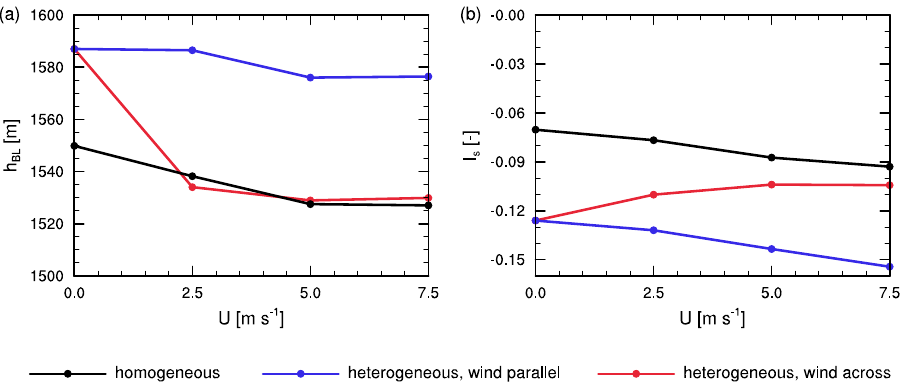
Fig. 9. Dependency of the boundary layer height (a) and the intensity of segregation in the boundary layer for Reaction (R9) (b) on horizontal wind. The plotted variables are averages over the fourth hour of simulated time. The boundary layer heights are additionally averaged in the x-direction. The black lines represent the numerical experiments with a homogeneous surface forcing , while the other two lines are based on cases with a heterogeneous surface forcing. For these cases, the wind can have two directions. The blue lines correspond to wind blowing parallel to the borders between the grass and savannah patches, i.e. in the y-direction, and the red lines correspond to wind blowing across these borders, i.e. in the x-direction.